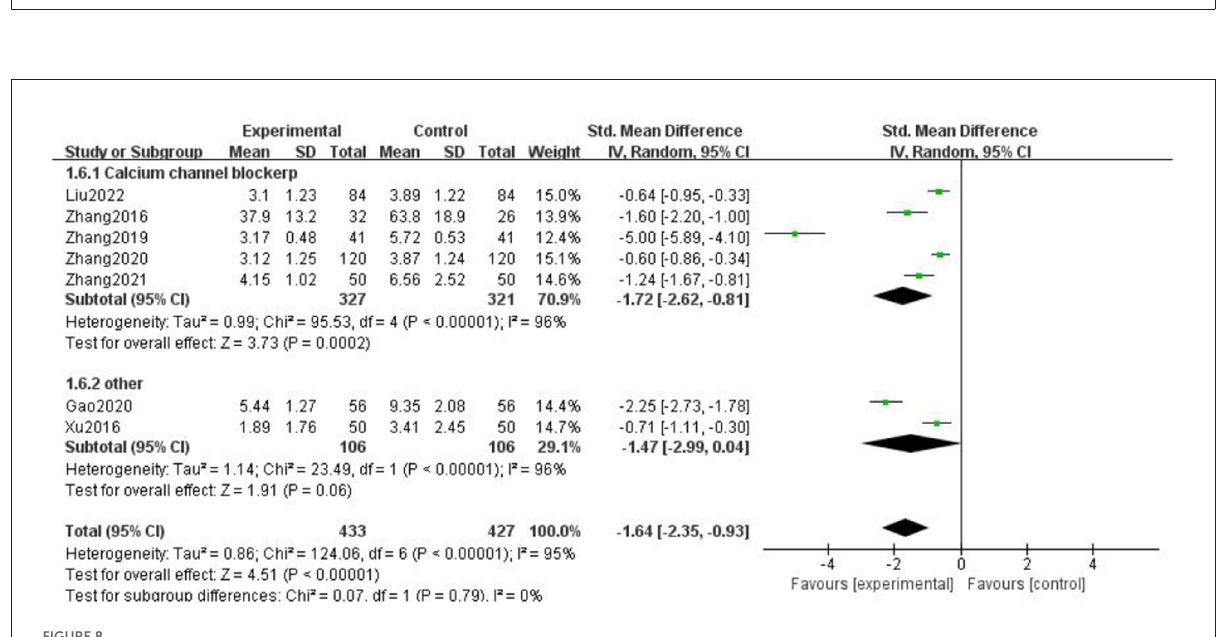
FIGURE8 Forest chart of headache duration divided into subgroups according to